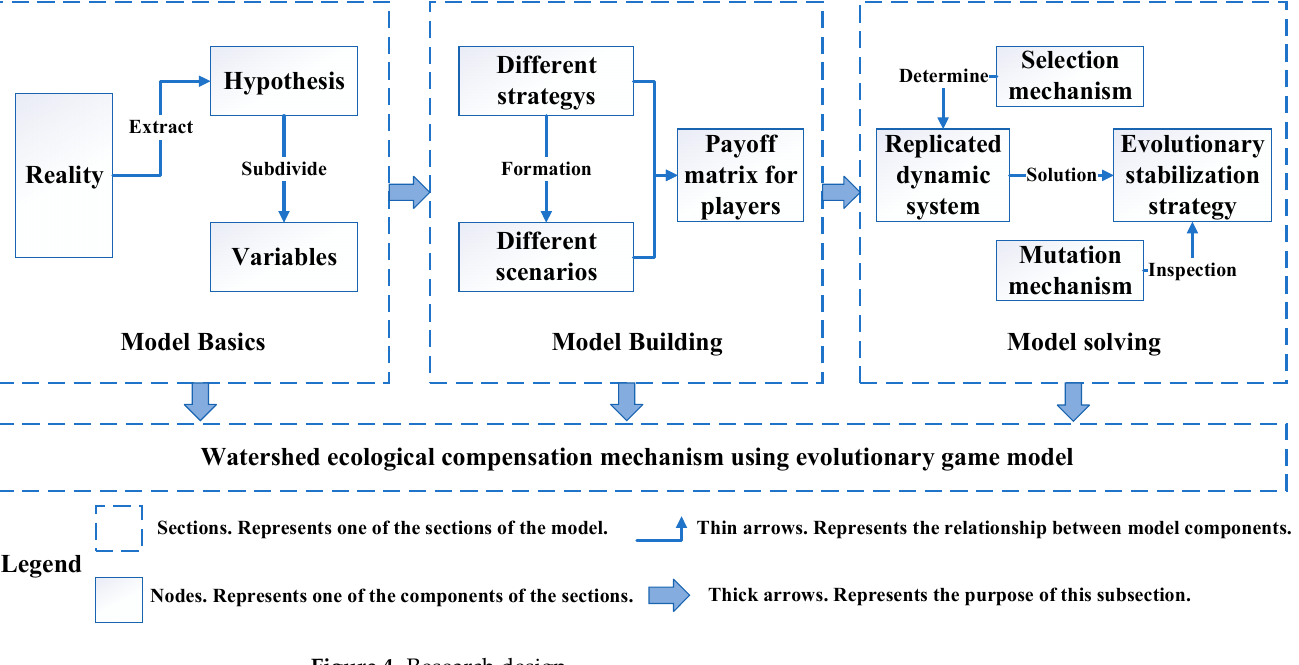
Figure 4. Research design.